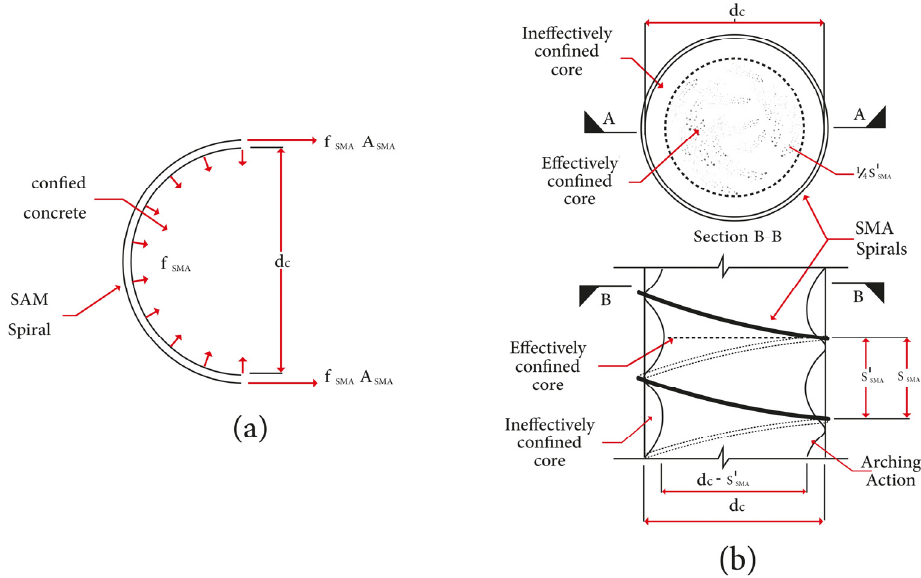
Figure 2. Schematic of confinement, ( a ) confinement forces ( b ) effective confinement of SMA-confined reinforced concrete columns.